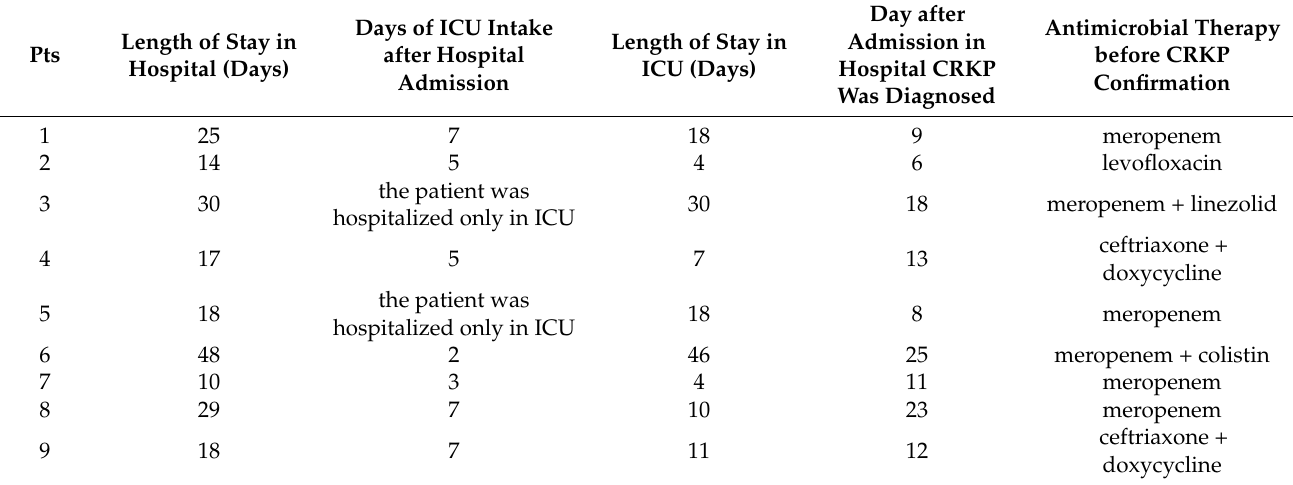
Table 2. Timing between hospital admission, CRPK diagnosis and treatment.